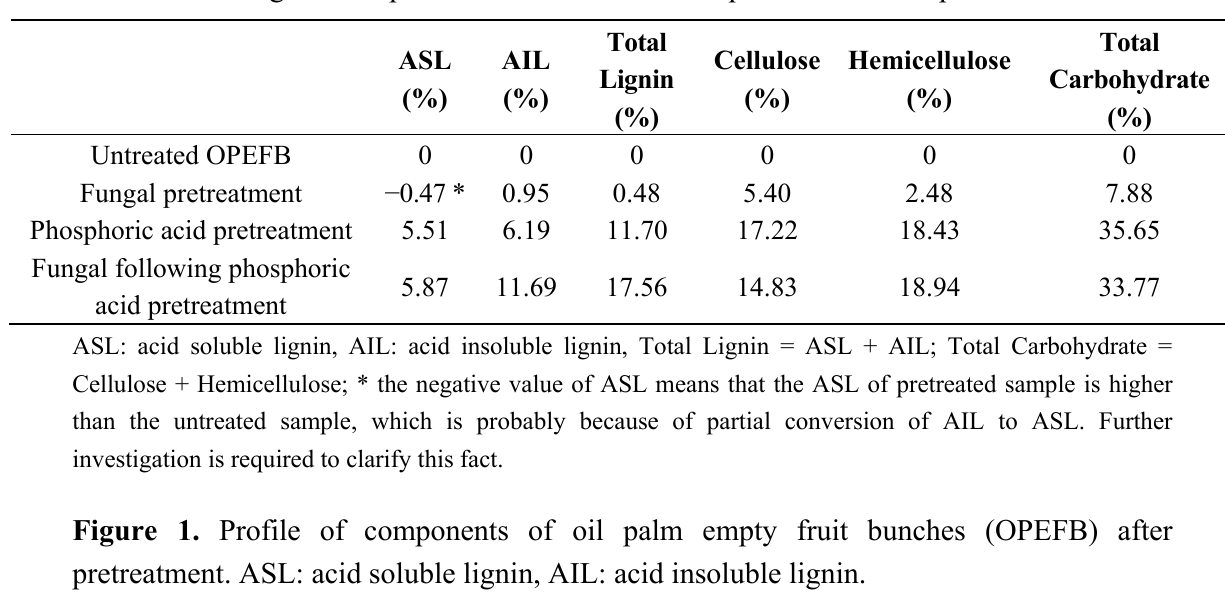
Table 2. Percentage of component loss of OPEFB after pretreatment compared to initial mass.